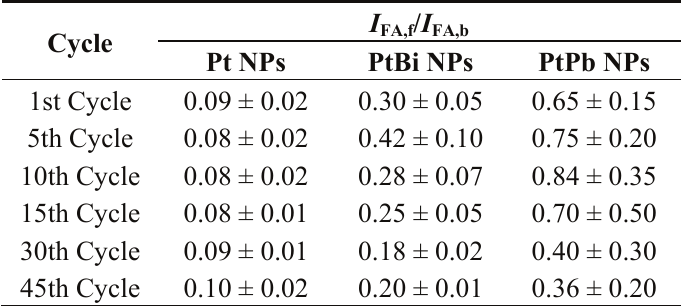
( I ) in 2 FA,f ( I ) in the backward sweep 2 FA,b